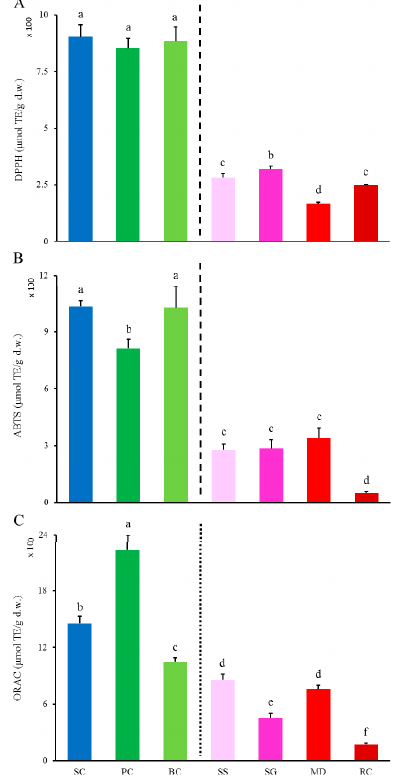
Figure 2. Antioxidant activities of S. cuneata and its six adulterants determined with DPPH ( A ), ABTS ( B ), and ORAC ( C ) assays. SC, PC, BC, SS, SG, MD, and RC were abbreviations of Sargentodoxa cuneata , Polygonum cuspidatum , Bauhinia championii , Schisandra sphenanthera , Schisandra grandiflora , Millettia dielsiana , and Rubia cordifolia in respective. Vertical dashed ( A and B ) / dotted ( C ) lines provide hints that data at the left side are far greater / greater than those on the right side. Different letters mean significant difference ( p > 0.05). Data are mean ± SD ( n = 3). As phenols were demonstrated as key bioactive compounds and antioxidant ability could be correlated to anti-inflammatory activity in SC, PC and BC possessed the highest potential of being candidate alternatives of SC because of their similar higher total phenols, total flavonoids, and antioxidant abilities (Figures 1 and 3). Among which, PC might be better than BC based further on the results of their ORAC values (Figure 2C) and inhibition abilities on radicals-induced supercoiled plasmid DNA strand scission (Figure 3C). Commented [M1]: Please check if there is an